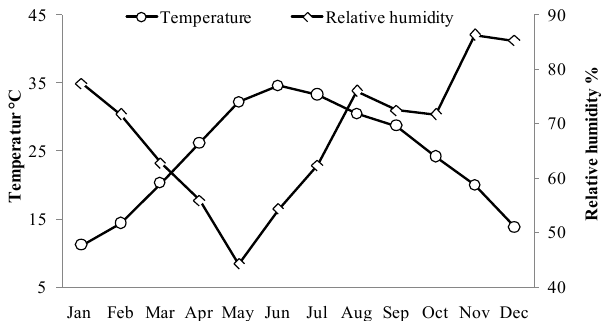
Fig 4 . Average monthly temperature and relative humidity at January to December,